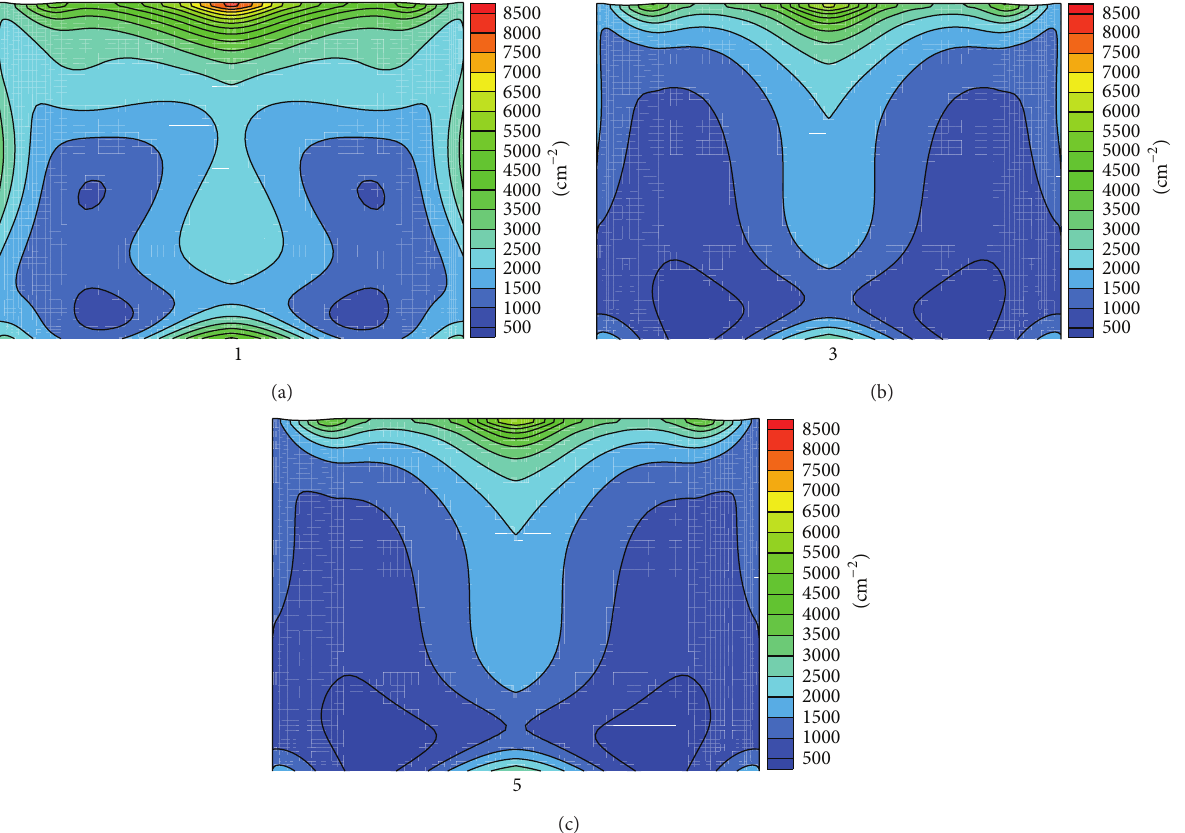
Figure 6: Dislocation density distributions at room temperature (1, 3, and